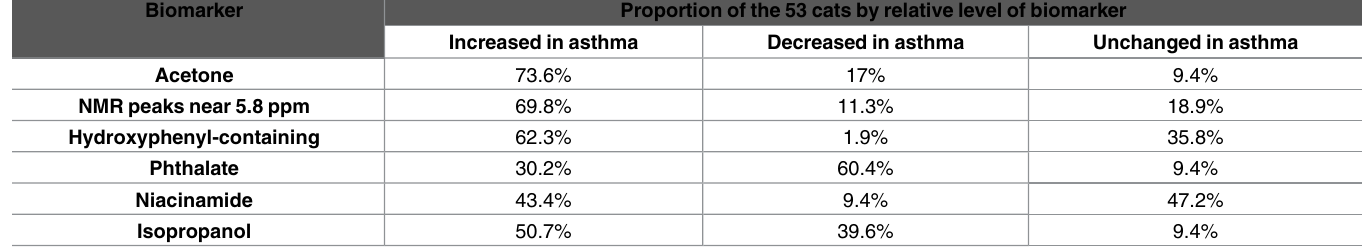
Table 2. Biomarkers of early allergic asthma in cats, ranked in descending order of diagnostic value. The relativesizes of the NMR peaks were com- pared across the 106 probabilistic quotient normalized spectra. Biomarker Proportion of the 53 cats by relative level of biomarker Increased in asthma Decreased in asthma Unchanged in asthma Acetone